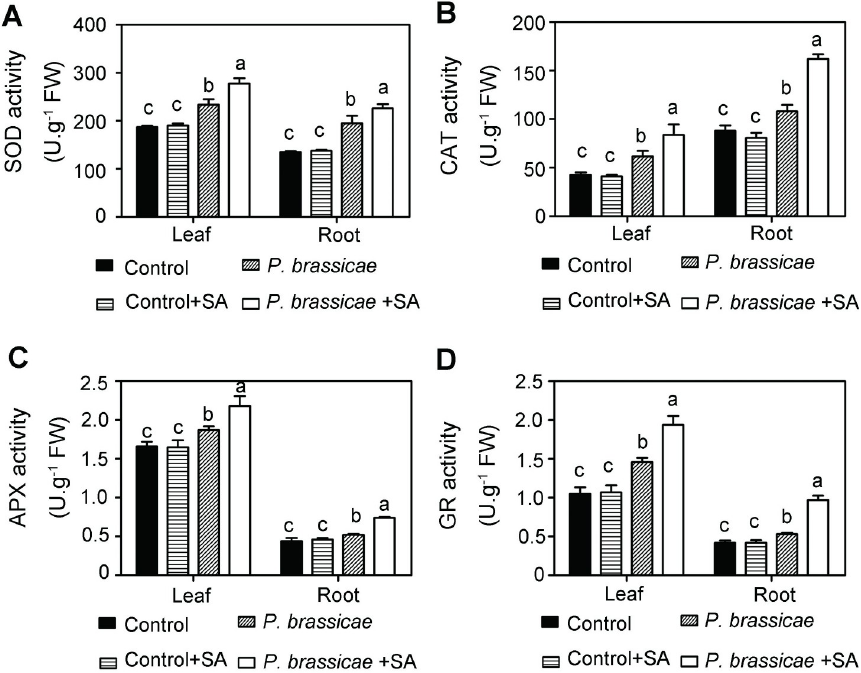
Fig 3. Antioxidant enzyme activities in pakchoi. SOD (A) , CAT (B) , APX (C) , and GR (D) activities in pakchoi were measured among four groups at 40 DAG. The data shown represent mean ± SD (n = 3). Different letters indicate significance (Tukey’s HSD test, P <